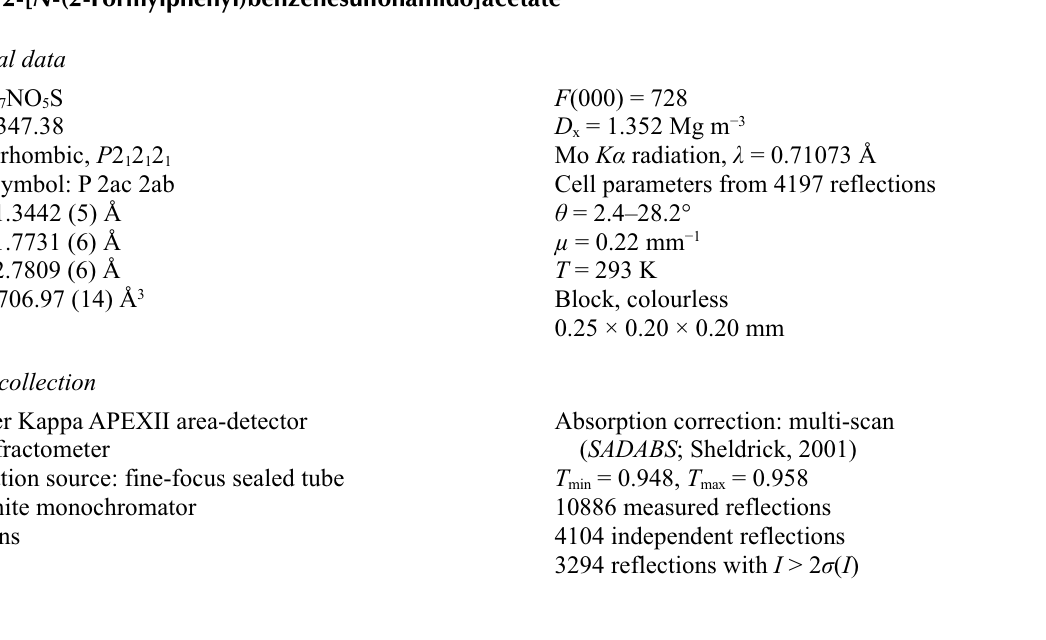
Crystal packing of the title compound. Hydrogen bonds are shown as dashed lines. Ethyl 2-[ N